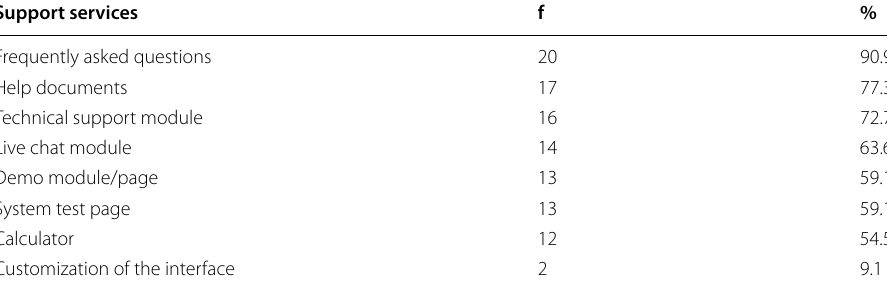
Table 10 Support services in online assessment